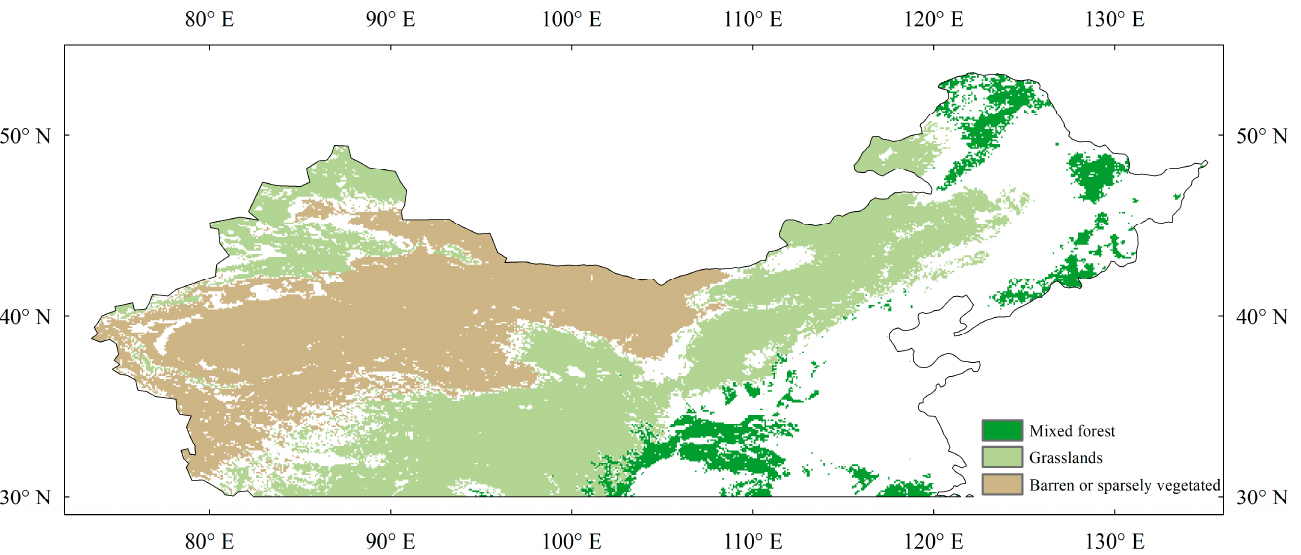
Figure 1. Vegetation types in temperate China.